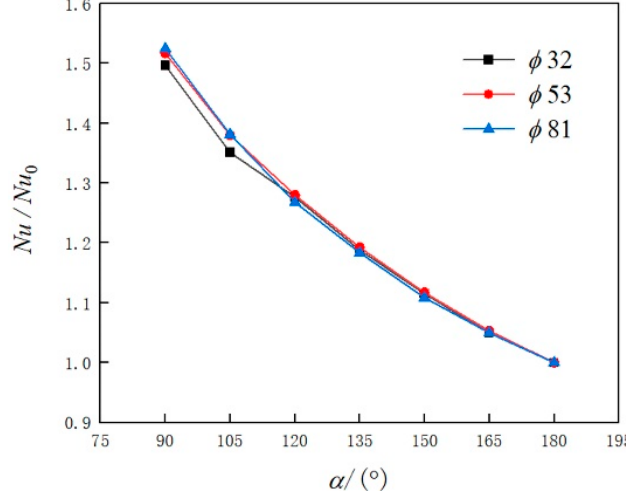
Figure 11. Relative Nusselt number Nu / Nu 0 changing with the central angle α for helical pipes.